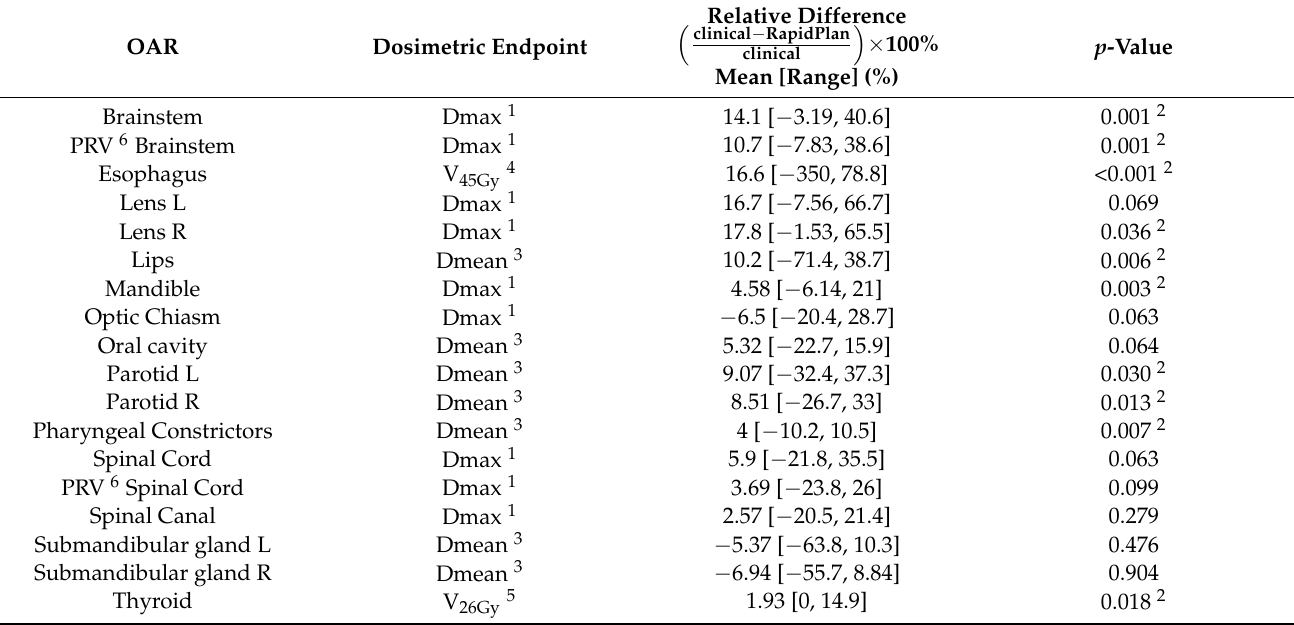
Table 3. Relative differences between clinical and RapidPlan™ plans of the 18 OARs for the open-loop validation